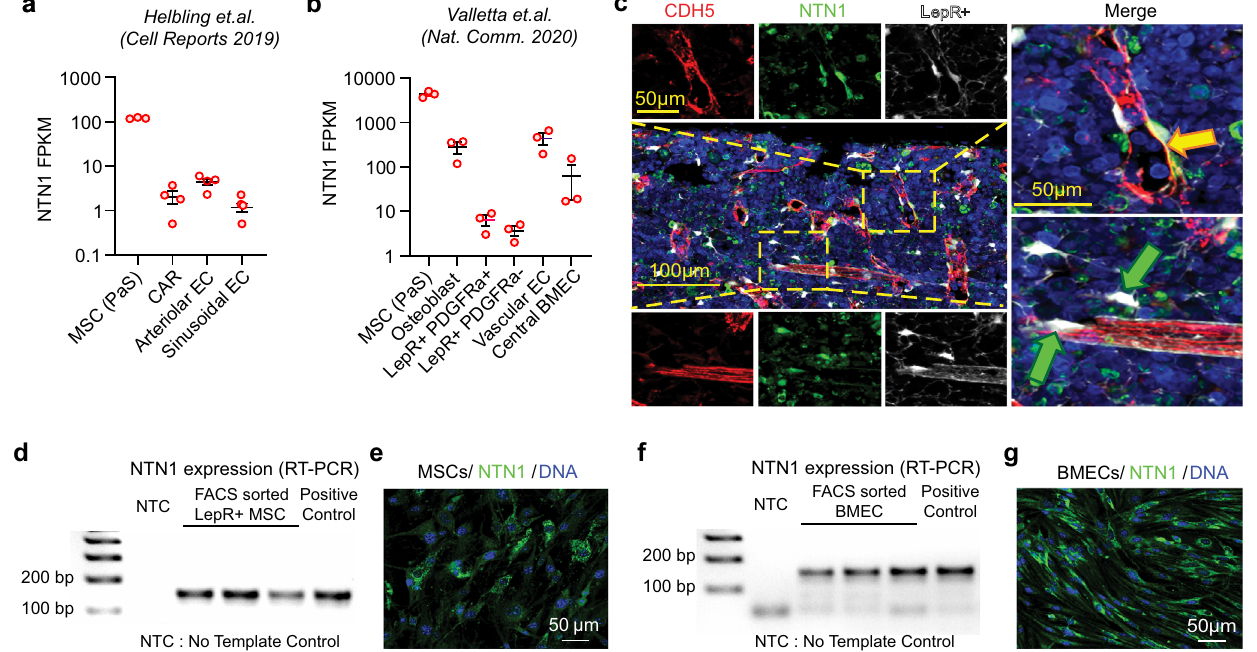
NTC : No Template Control Green:NTN1expressiondetectedbyananti-NTN1antibody.( N =3mice). d RT-PCR analysis demonstrating NTN1 expression within FACS puri fi ed LepR+ MSCs (de fi ned as CD45 - TER119 - VECAD - CD31 - LepR + ) within the BM ( N =3 mice/group). e Representative IF images of cultured BM MSCs showing NTN1 expression. ( N =1 cell line/group). f RT-PCR analysis demonstrating NTN1 expression within FACS- puri fi ed BMECs (de fi ned as CD45 - TER119 - LepR - VECAD + CD31 + ) within the BM. ( N =3 mice/group). g Representative IF images of cultured BMECs showing NTN1 expression. ( N =1 cell